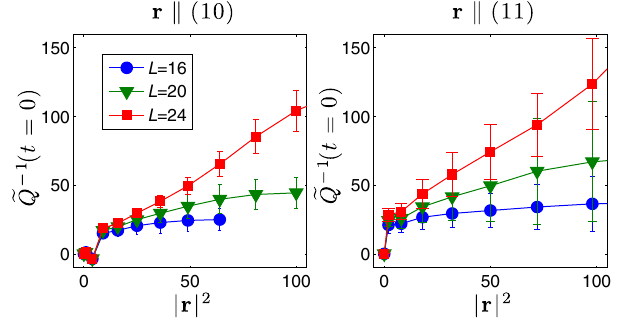
FIG. 25. The inverse of the equal time quadrupolar correlator at h ¼ h and T ¼ 0 . 1 , plotted versus the square of the spatial c separation r along high-symmetry directions for several system sizes. In contrast to the data of Fig. 13, substantial tetragonal anisotropy can be seen by comparing the left-hand panel (horizontal displacements) and the right-hand panel (diagonal displacements). However, the data apparently represent the thermodynamic limit only for j r j ≲ 4 , and therefore we cannot reliably extract long-distance